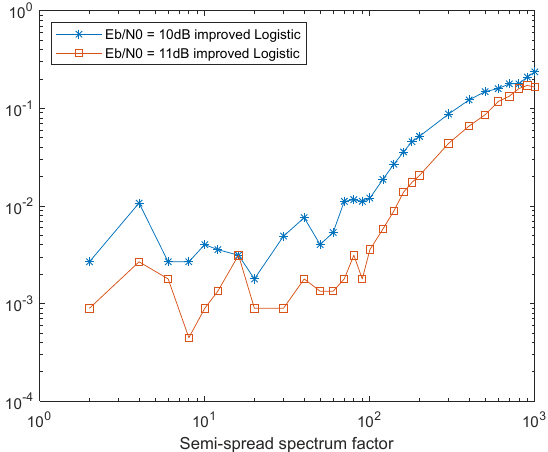
Figure 11. Relationship between semi − spread spectrum factor and bit error rate.